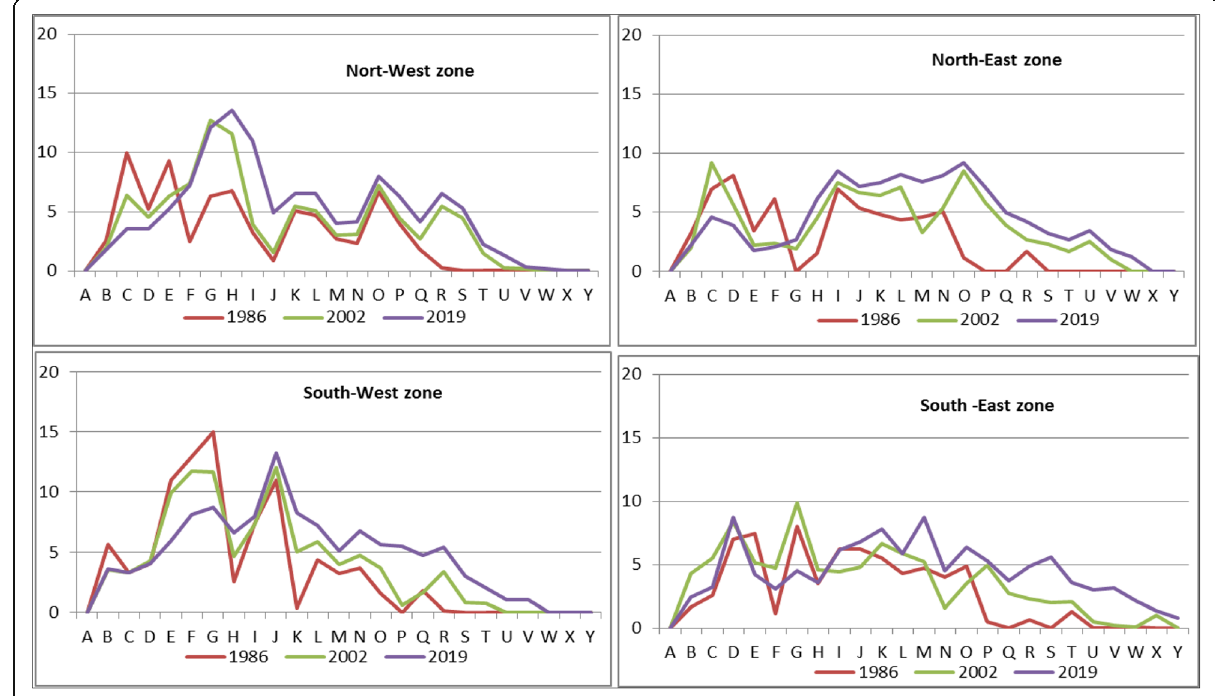
Fig. 6 Percentage of zone-wise distribution of built-up area within each